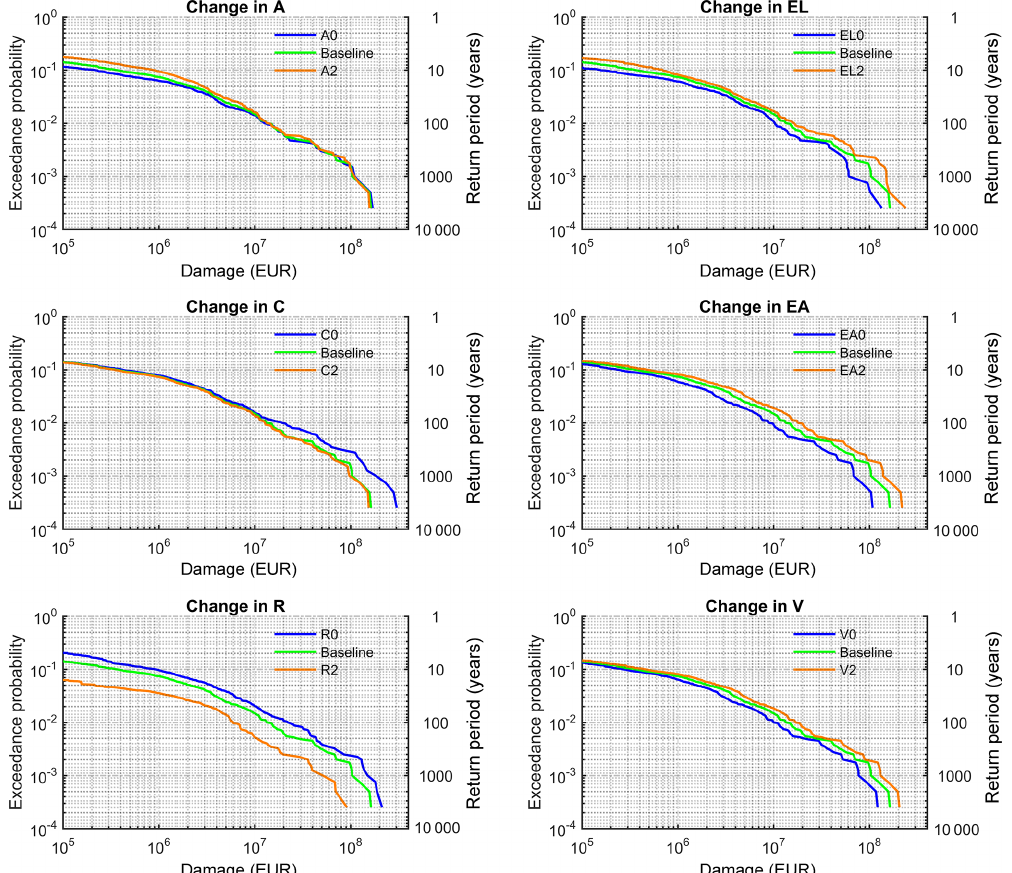
Figure 6. Risk curves, for damages aggregated to the catchment scale, for changes in six components: atmosphere (A), catchment (C), river system (R), land use (EL), asset values (EA), and vulnerability (V) under baseline conditions. Baseline represents baseline scenarios for each component, which is denoted by A1C1R1EL1EA1V1. All change scenarios vary only in the respective component. For example, A0 means